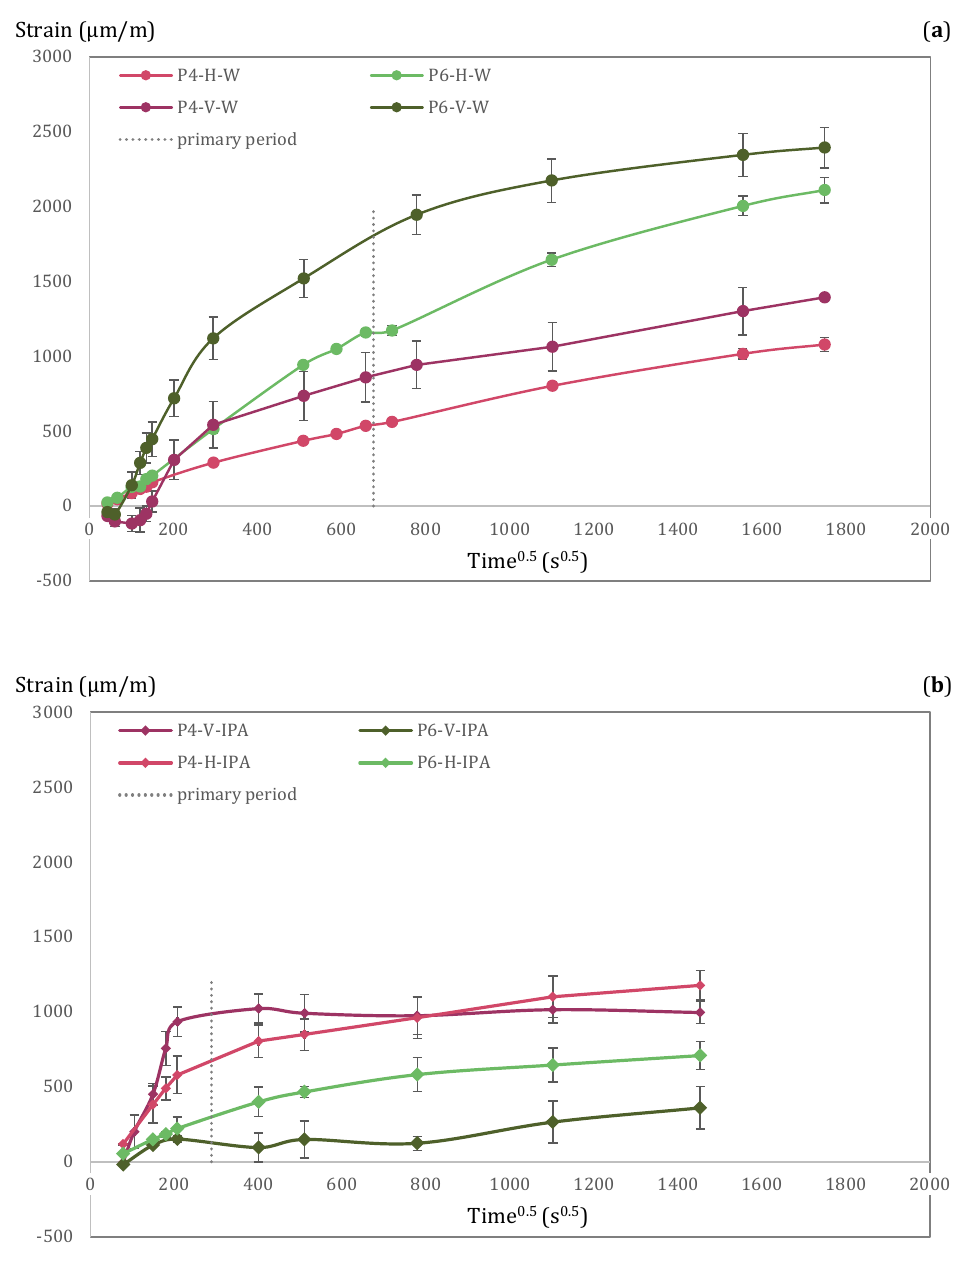
Figure 9. Vertical (V) and horizontal (H) deformations of cement pastes P4 and P6 registered during long-term capillary imbibition with water ( a ) and IPA ( b ) as imbibing liquids.